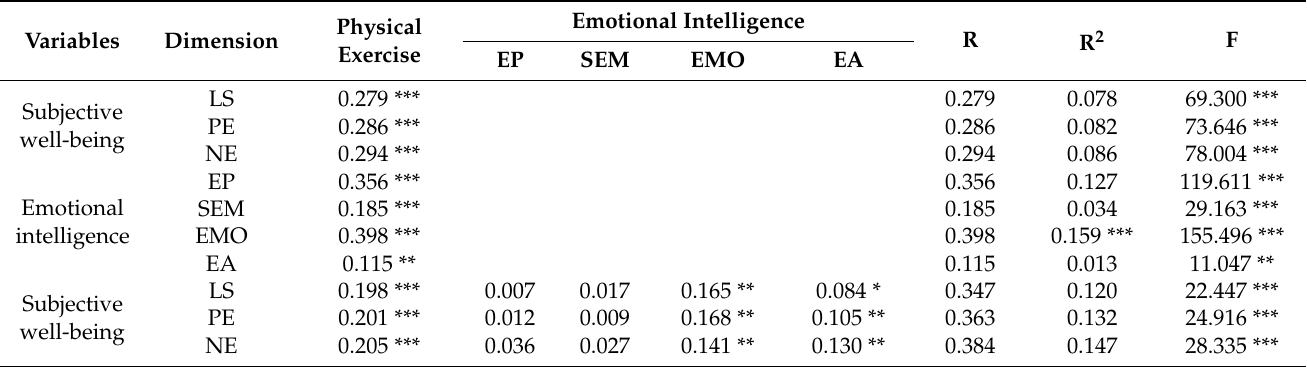
Table 5. Regression analysis among sub-dimensions of physical exercise, emotional intelligence, and subjective well-being.